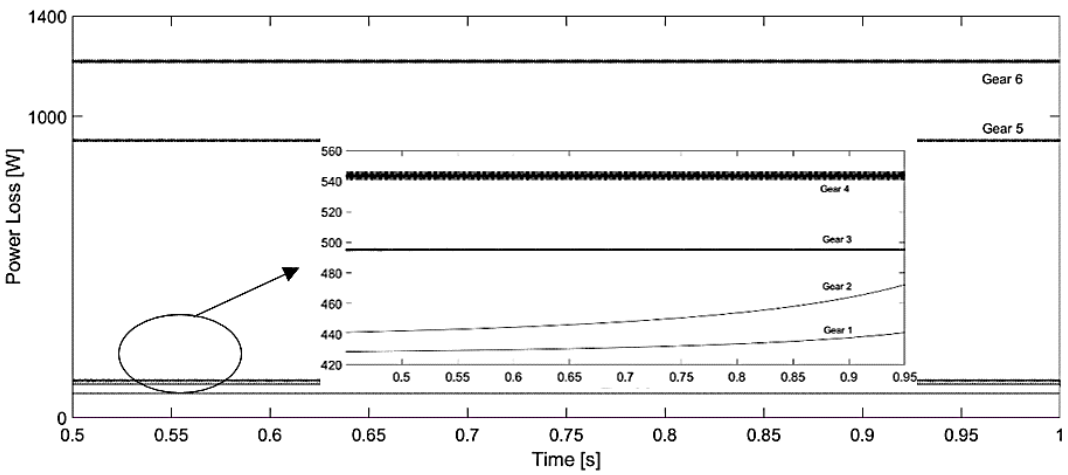
Figure 13. Power losses for uncoated gears, scenario 2.